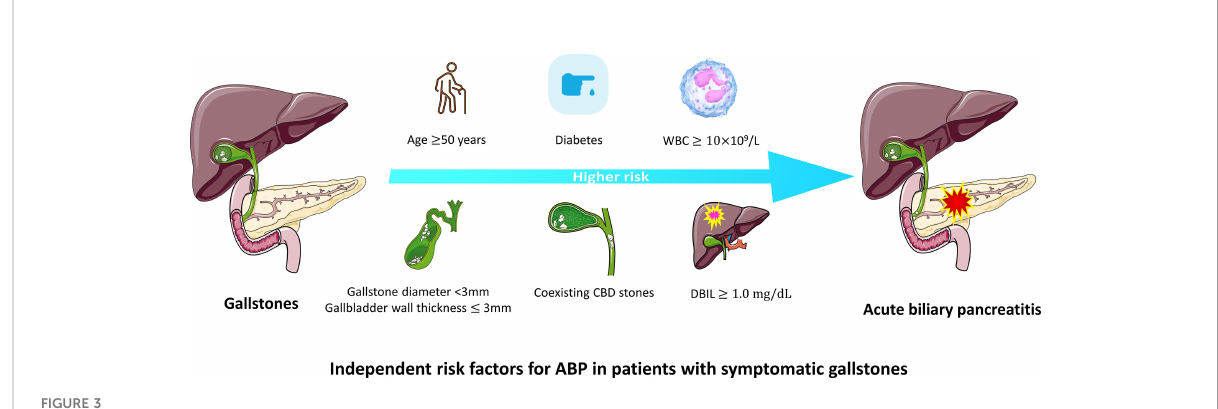
FIGURE 3 Independent risk factors for ABP in patients with